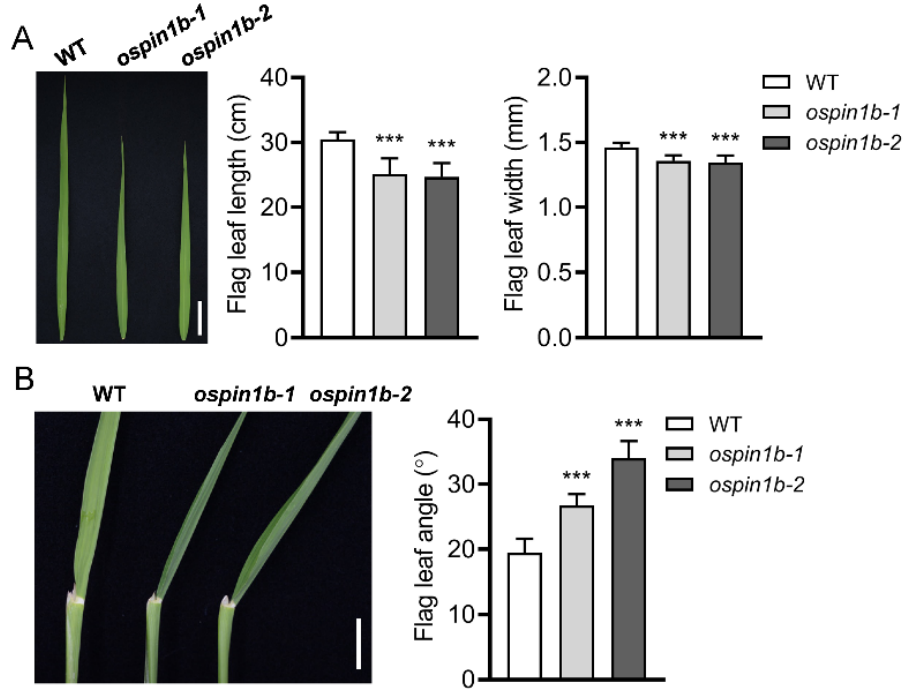
Figure 6. The phenotype of leaves in wild-type (WT) and ospin1b mutants at the heading stage. ( A ) Leaf length and width. Bar = 4 cm. ( B ) Leaf angle. Bar = 1 cm. Values are means ± standard deviation (SD) ( n = 16). Data were analyzed by ANOVA and Tukey’s tests. ***: p < 0.001. 2.7. Loss of function of OsPIN1b Leads to Decreased Plant Height, Increased Tiller Number, Reduced Panicle Length and Increased Grain Yield at the Mature Stage At the mature stage, the ospin1b mutants exhibited a clear phenotype, including decreased plant height, increased tiller number and shorter panicle compared with WT plants. The plant height of ospin1b mutants was significantly reduced by 6–7%, while the tiller number greatly increased by 47–51% compared with WT plants (Figure 7A). ospin1b mutants also had a decrease in the panicle length of about 20%, leading to a decrease in grain number per panicle relative to control plants of about 32% (Figure 7B). However, the grain yield per plant of ospin1b was significantly increased by 15–17% compared to wild-type plants, which was mainly attributed to the increased tiller number (Figure